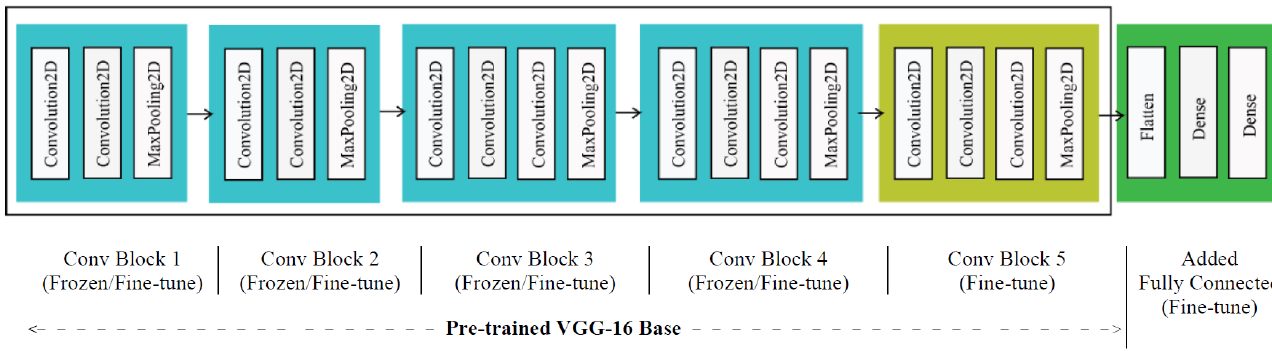
Figure 4. Illustration of the proposed Emotion Recognition model with VGG-16 model plus dense (i.e., fully connected) layers. VGG-16 model is pre-trained on ImageNet dataset. A block with ‘Fine-tune’ mark is essential to fine-tune and a block with ‘Frozen/Fine-tune’ mark is optional to fine-tune.